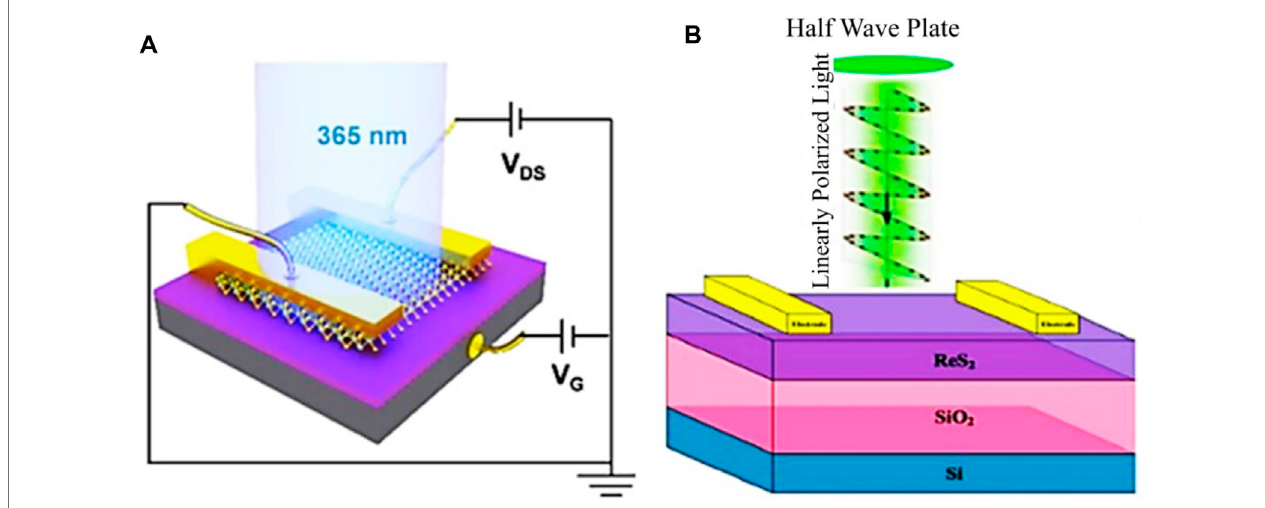
FIGURE 8| (A) Schematic of MoS 2 single-layered phototransistor (George et al., 2021), and (B) Schematic ofReS 2 photodetector (Liu et al., 2016a); Reproduced with permission from (Liu et al., 2016a; George et al., 2021).